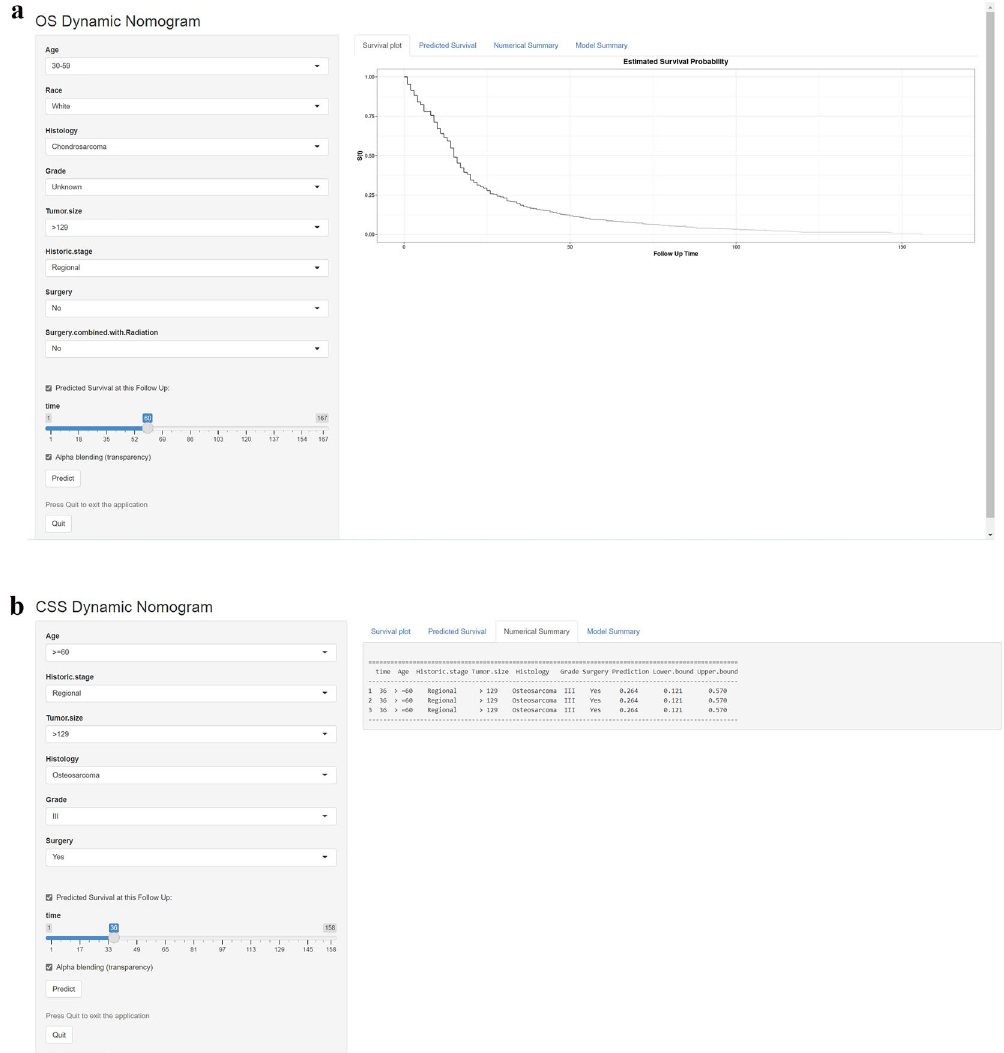
Figure 3. Web-based survival rate calculator used to predict non-metastatic PMBS patient OS ( a ) and CSS ( b ).